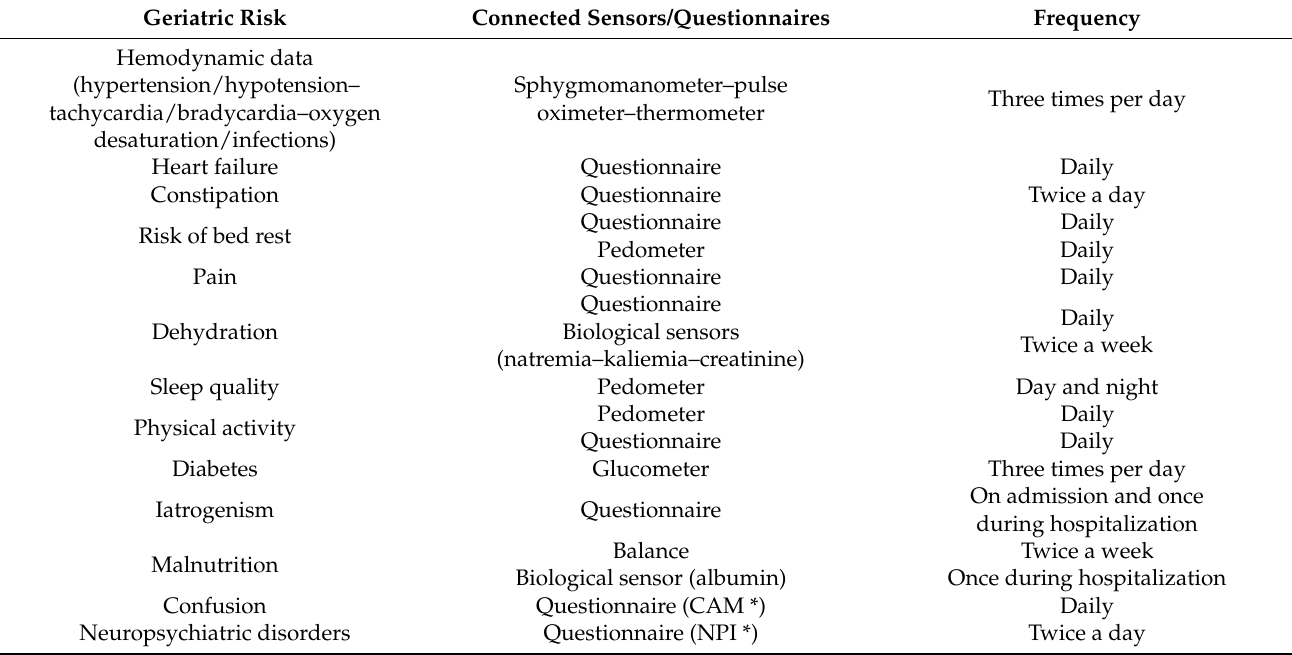
Table 1. Remote monitoring of geriatric risks in the GER-e-TEC study